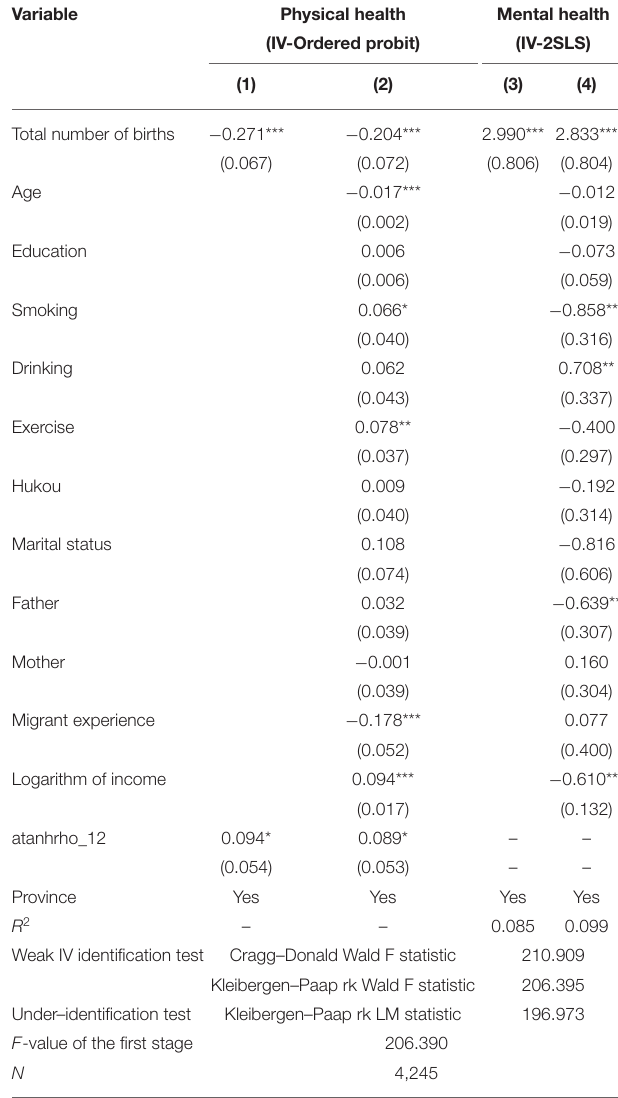
TABLE 3 | Impacts of fertility on physical and mental health of women of childbearing